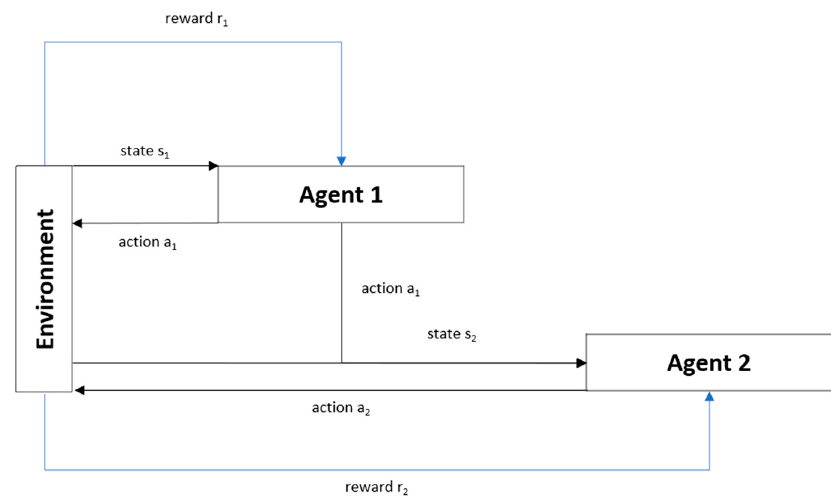
Figure 4. Cooperative multiagent deep reinforcement learning (DRL) architecture.